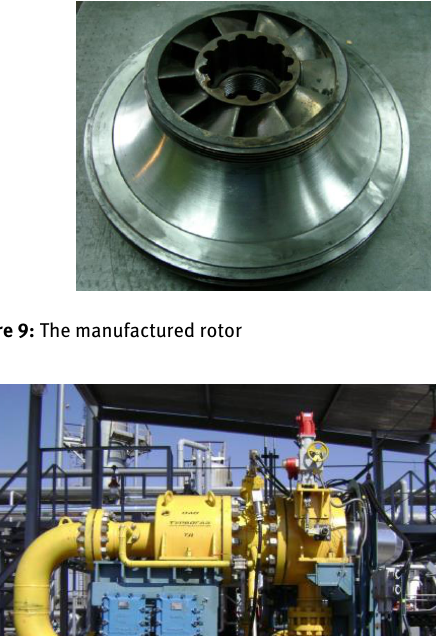
condenser is set at 363 K at the saturation pressure of